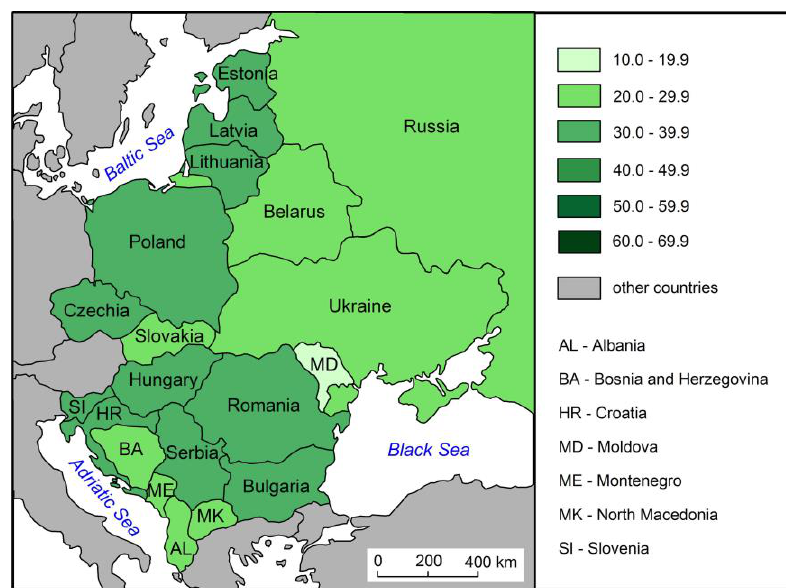
Fig. 3. Projected old-age dependency ratio in 2020 (Source: United Nations, 2019a)